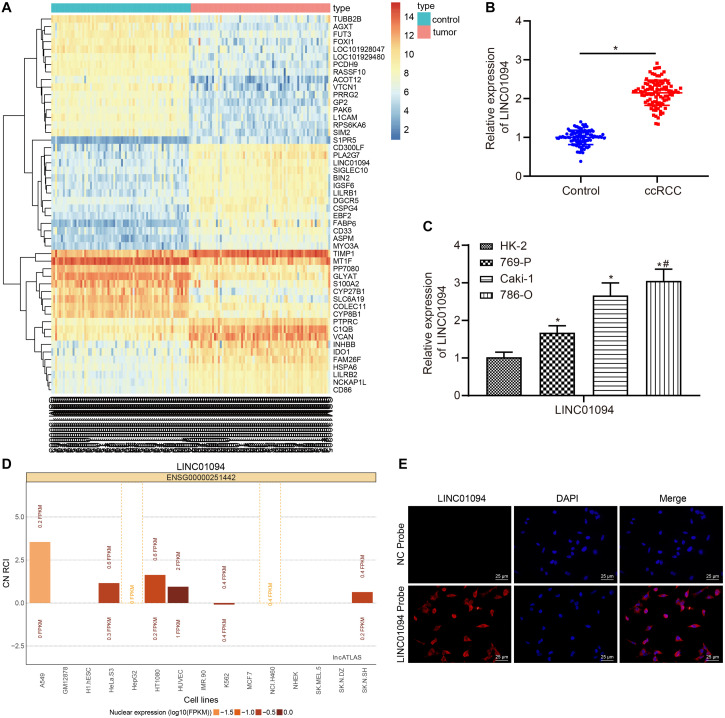
High expression of LINC01094 was found in clear cell renal cell carcinoma (ccRCC) tissues and cells. (A) Heat map of 50 differential expressed genes in the ccRCC-related microarray dataset GSE53757. The X-axis represents the sample number and the Y-axis represents the differentially expressed gene. Each rectangle in the Figure corresponded to the expression of a gene in a sample. (B) The expression of LINC01094 in clinical ccRCC and adjacent normal tissues detected by reverse transcription-quantitative polymerase chain reaction (RT-qPCR). (C) The expression of LINC01094 in different cell lines evaluated by RT-qPCR. (D) The subcellular location of LINC01094 according to LncATLAS database. CN RCI refers to the ratio of long non-coding RNA (lncRNA) expression in the cytoplasm and in the nucleus of a cell line. FPKM, Fragments per kilobase of exon model per million mapped fragments. (E) The subcellular localization of LINC01094 measured by FISH (400 ×). LINC01094 showed red fluorescence and the nucleus showed blue fluorescence. * p < 0.05 vs. the control group or HK-2, # indicated the cell line with the highest expression of LINC01094. The data are measurement data and expressed as mean ± SD. Paired t-test is performed for comparison between ccRCC tissues and adjacent normal tissues. One-way ANOVA is used to compare data among multiple groups, and Tukey’s was used for post hoc tests.